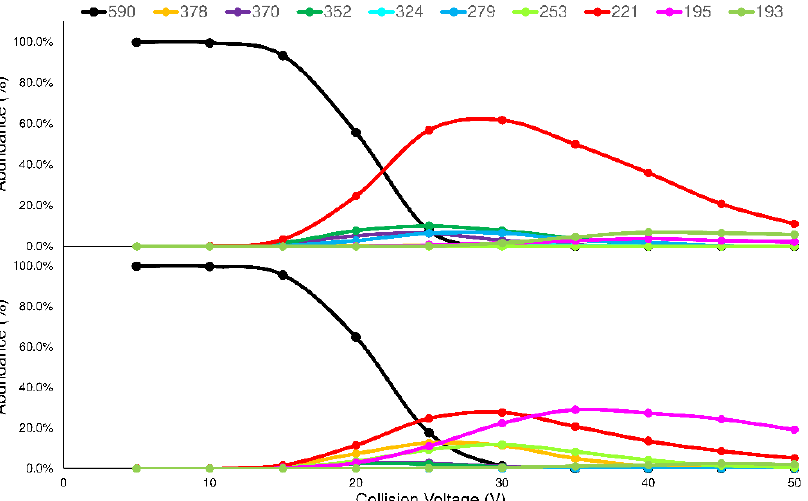
Figure 3. Comparison between the breakdown curves of selected MS/MS transitions of FRA76 (top) and GDE5 (bottom) isomers.